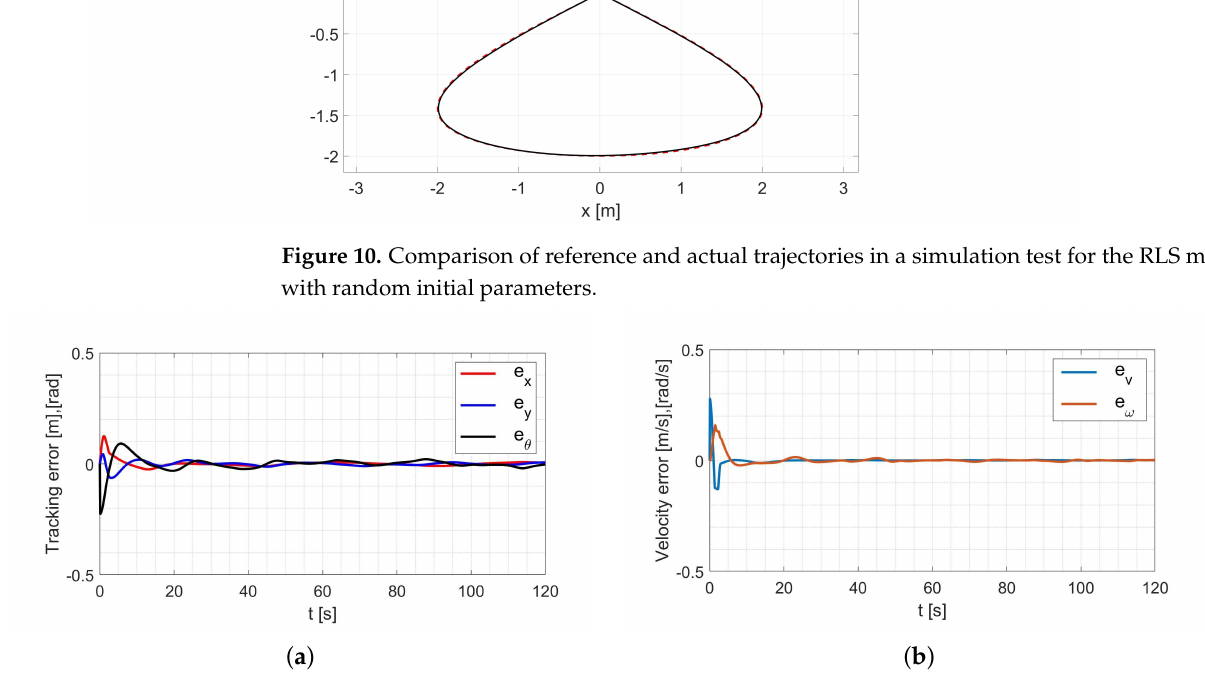
Figure 11. Errors for the RLS method with random initial parameters: ( a ) tracking the reference trajectory ( b )